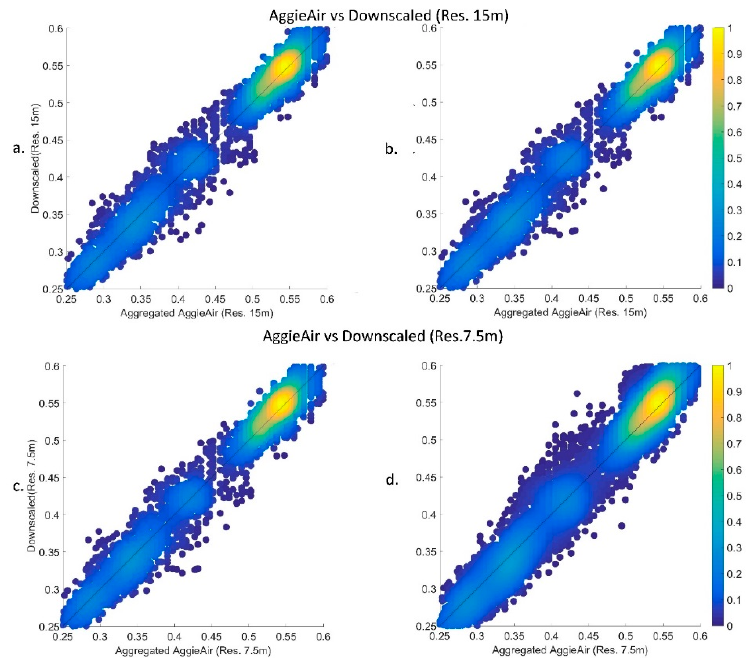
Figure 5. Pixel-wise comparison of AggieAir imagery versus downscaled NIR images as at resolution 15 and 7.5 m for the first ( a , c ) and second ( b , d ) scenarios, respectively. Table 1. The root mean squared error (RMSE) quantifying the quality of the downscaling scheme for different scaling factors for all spectral bands.